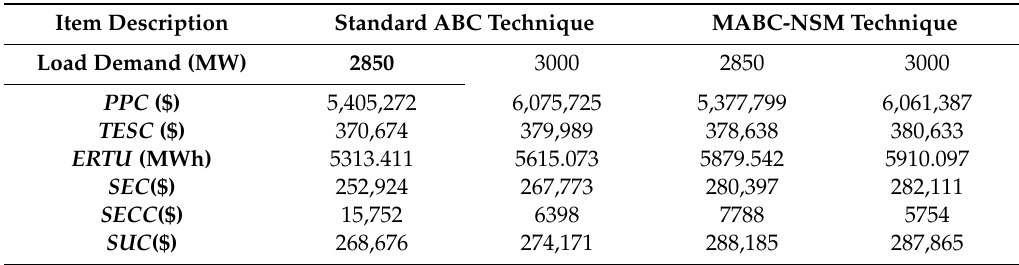
Table 6. Comparison of SUC results obtained based on the standard Artificial Bee Colony (ABC) and MABC-NSM algorithm. ERTU : energy reduction of thermal units, PPC : probabilistic production